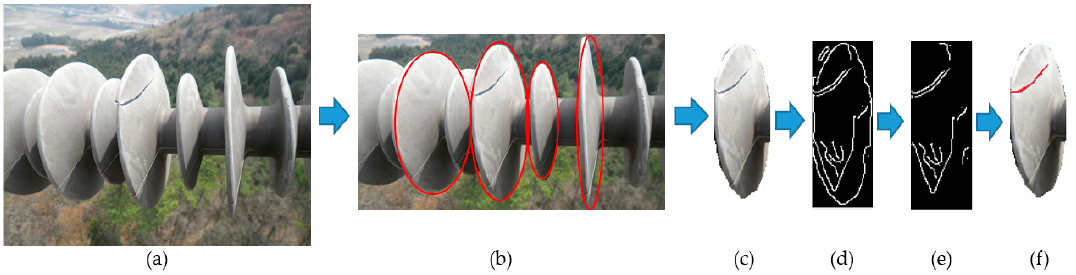
Figure 12. The process of splits detection in polymer insulator. ( a ) The input image, ( b ) ellipse detection result, ( c ) one of the segmented cap, ( d ) edge map, ( e ) edge map after boundary removal, and ( f ) splits detection result.